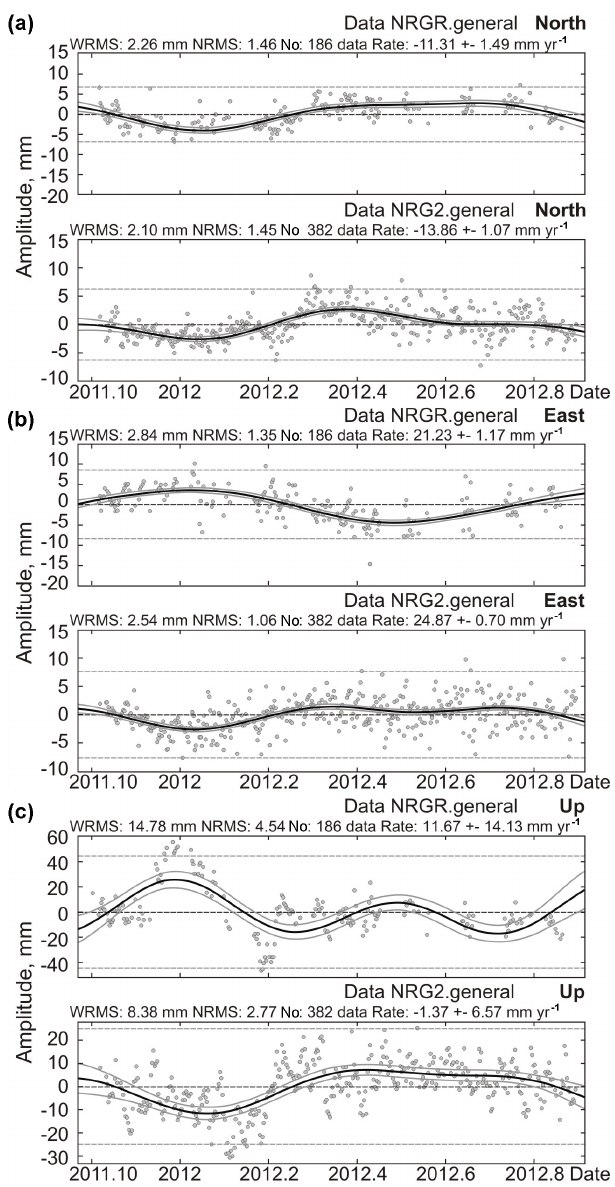
Figure 3. The dynamics of displacement components of NRGR and NRG2 station daily positions in different directions: (a) for the N–S components; (b) for the E–W components; (c) for the vertical (up– down)